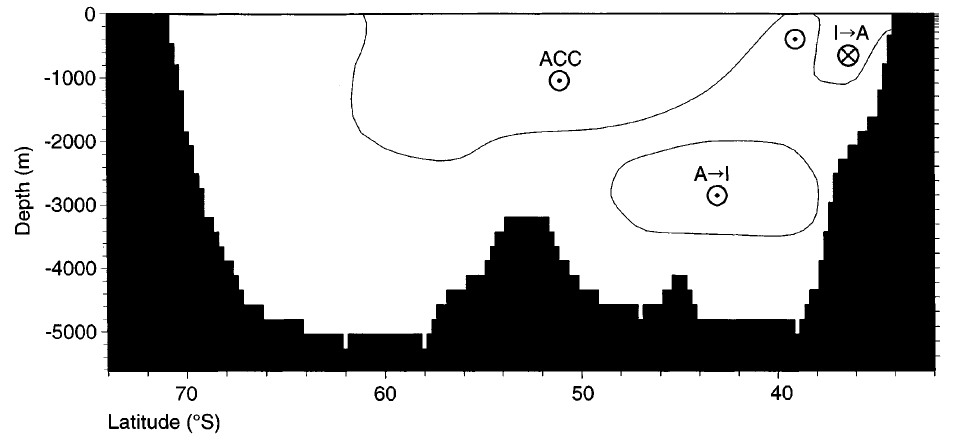
Fig. 10. A schematic meridional section along 20 (cid:14) E between Ant- arctica at 72 (cid:14) S and South Africa at 33 (cid:14) S. The arrowhead and arrowtail symbols indicate water flowing eastwards and westwards respectively